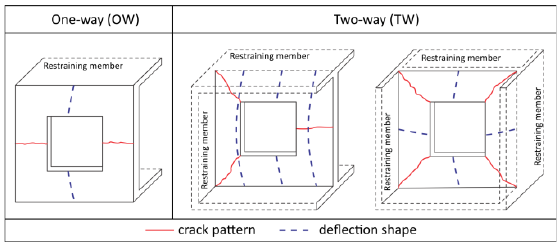
Figure 1. One-way and two-way behavior of axially loaded RC walls. Adapted from Popescu et al.